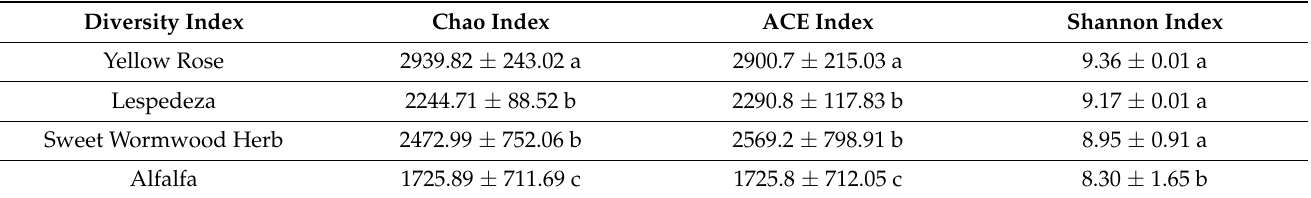
Table 2. Microbial community diversity index of reclaimed soils with different vegetation